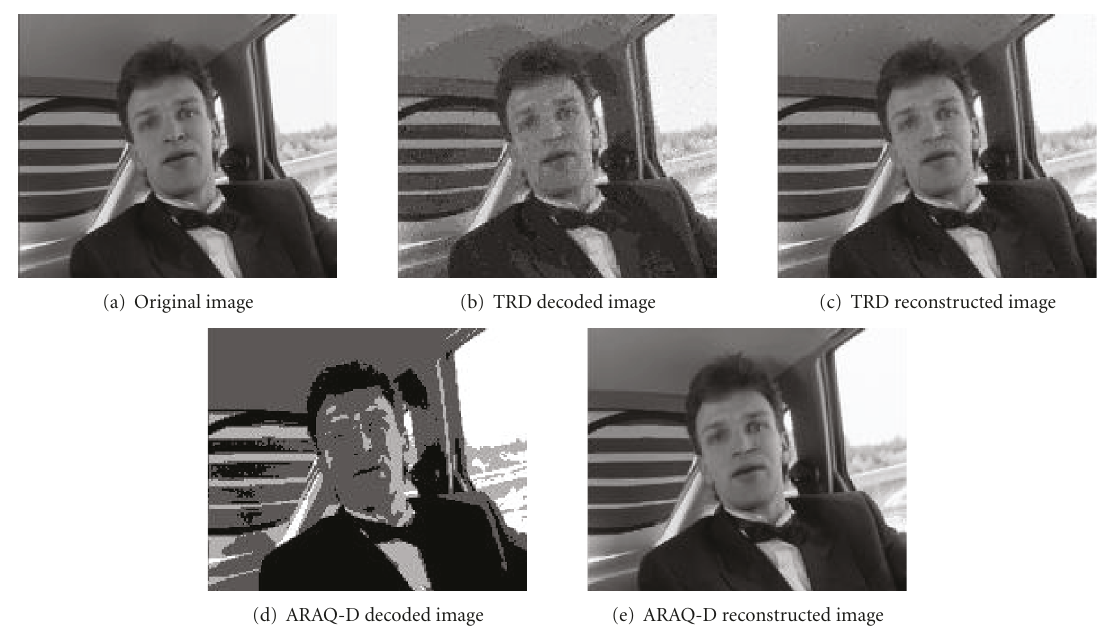
Figure 13: Snapshot from the Carphone sequence. (a) Original image. (b) TRD turbo decoded image with M = 4 and ρ = 0 . 21875. (c) Reconstructed image from (b). (d) ARAQ-D turbo decoded image with M = 2 and ρ = 0 . 4375. (e) Reconstructed image from (d).